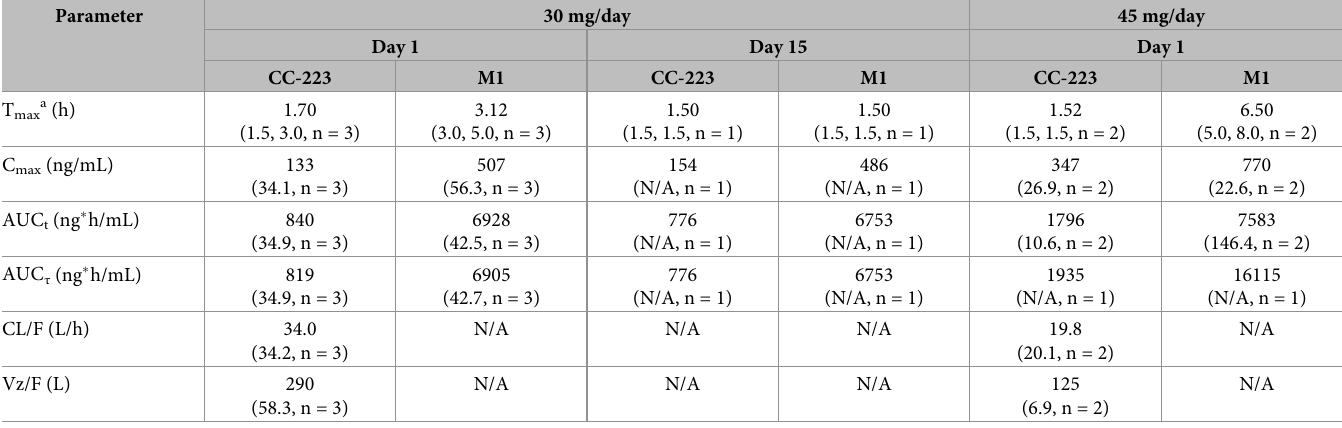
Data are presented as geometric mean (%CV, n), except where indicated. AUC t , area under the plasma concentration-time curve from time 0 to the last measurable concentration at time t; AUC , area under the plasma concentration-time curve from time 0 to τ , where τ is the dosing interval; CL/F, apparent total body clearance; τ C max , maximum observed concentration in plasma; CV, percentage coefficient of variation; h, hour; N/A, not applicable; T max , time to maximum concentration; Vz/F, apparent volume of distribution. a Median (min, max, n) data are